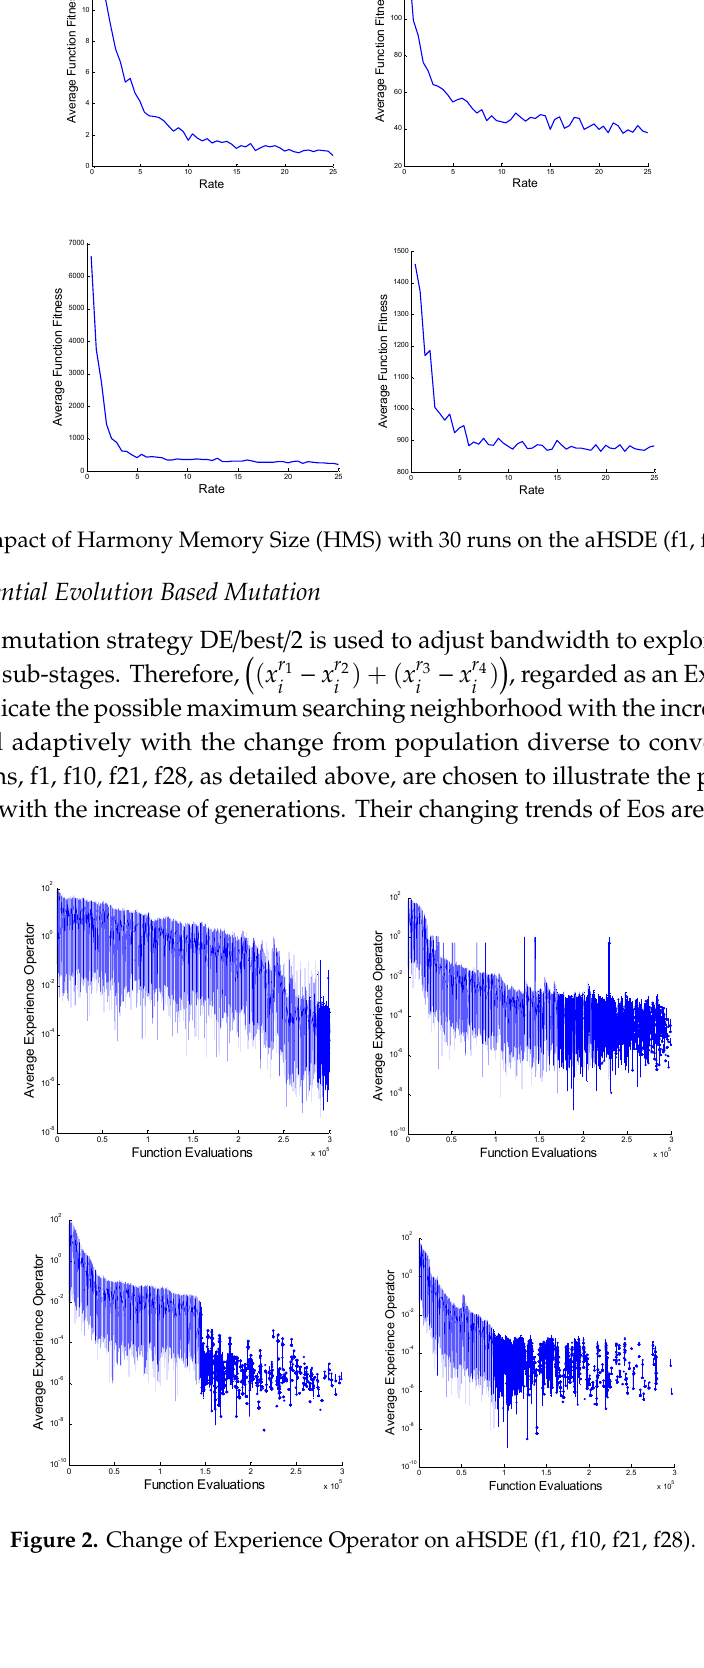
Figure 1. Impact of Harmony Memory Size (HMS) with 30 runs on the aHSDE (f1, f10, f21, f28).